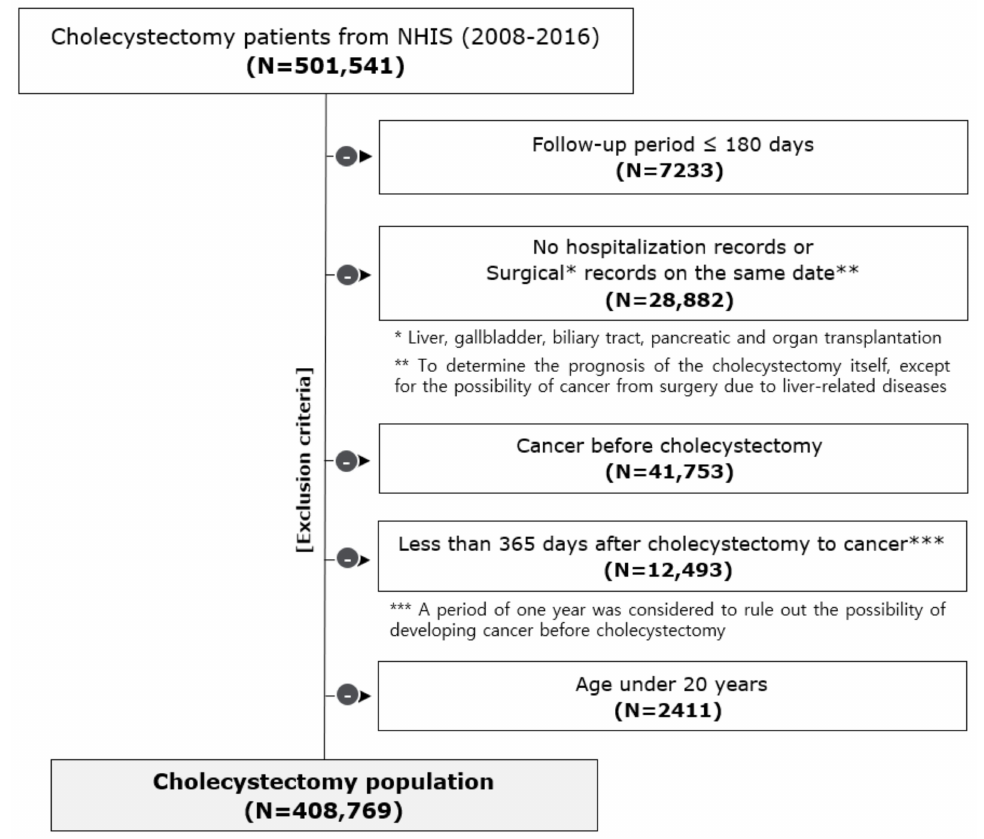
Figure 1. Flow diagram of the selection process of the study population. This study included 501,541 patients who underwent cholecystectomy from 2008 to 2016 using the National Health Insurance Service (NHIS) database. According to the exclusion criteria of this study, a total of 408,768 patients were included in the final